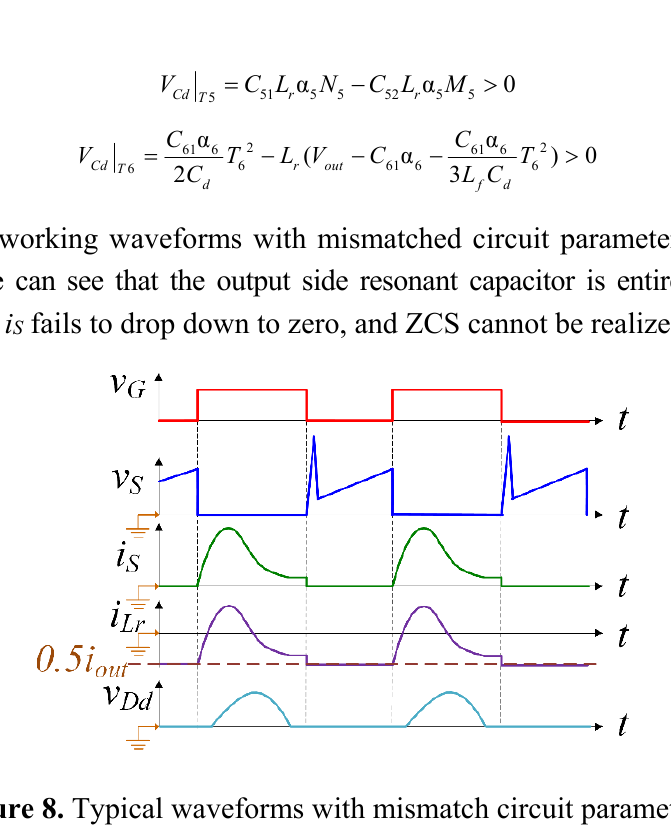
Figure 8. Typical waveforms with mismatch circuit parameters.